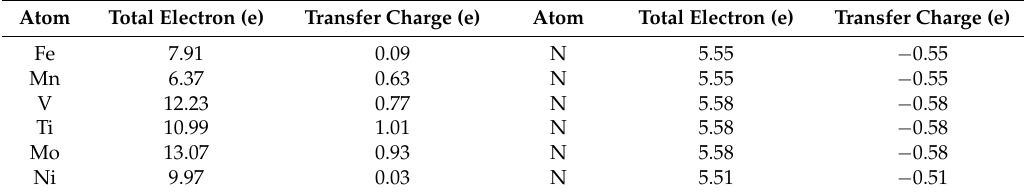
Table 2. Atomic charges on the nitrogen atoms and M (M = Mn, V, Ti, Mo, and Ni) atoms closed to the clean interface and that after M atom introduced calculated from Mulliken population